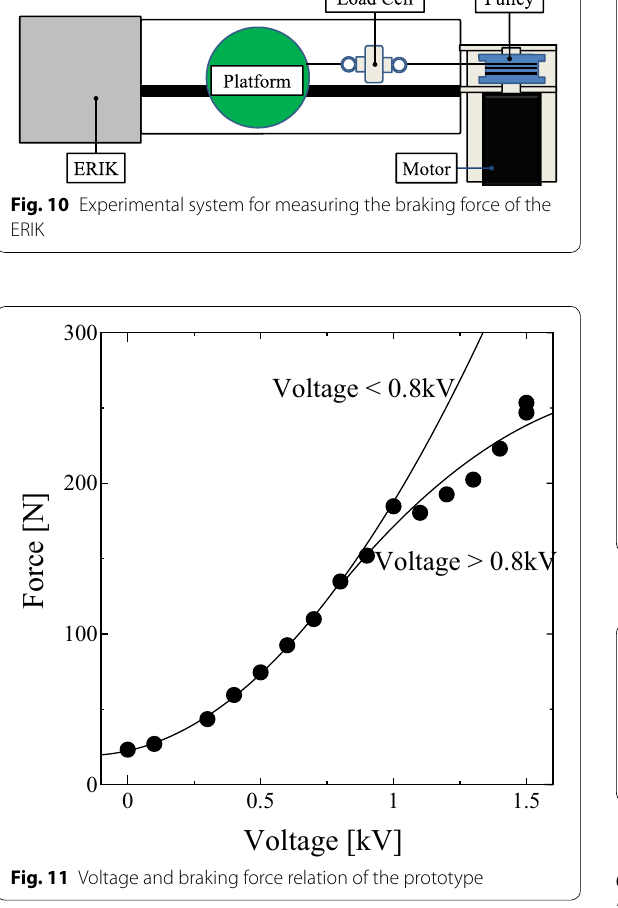
Fig. 11 Voltage and braking force relation of the prototype